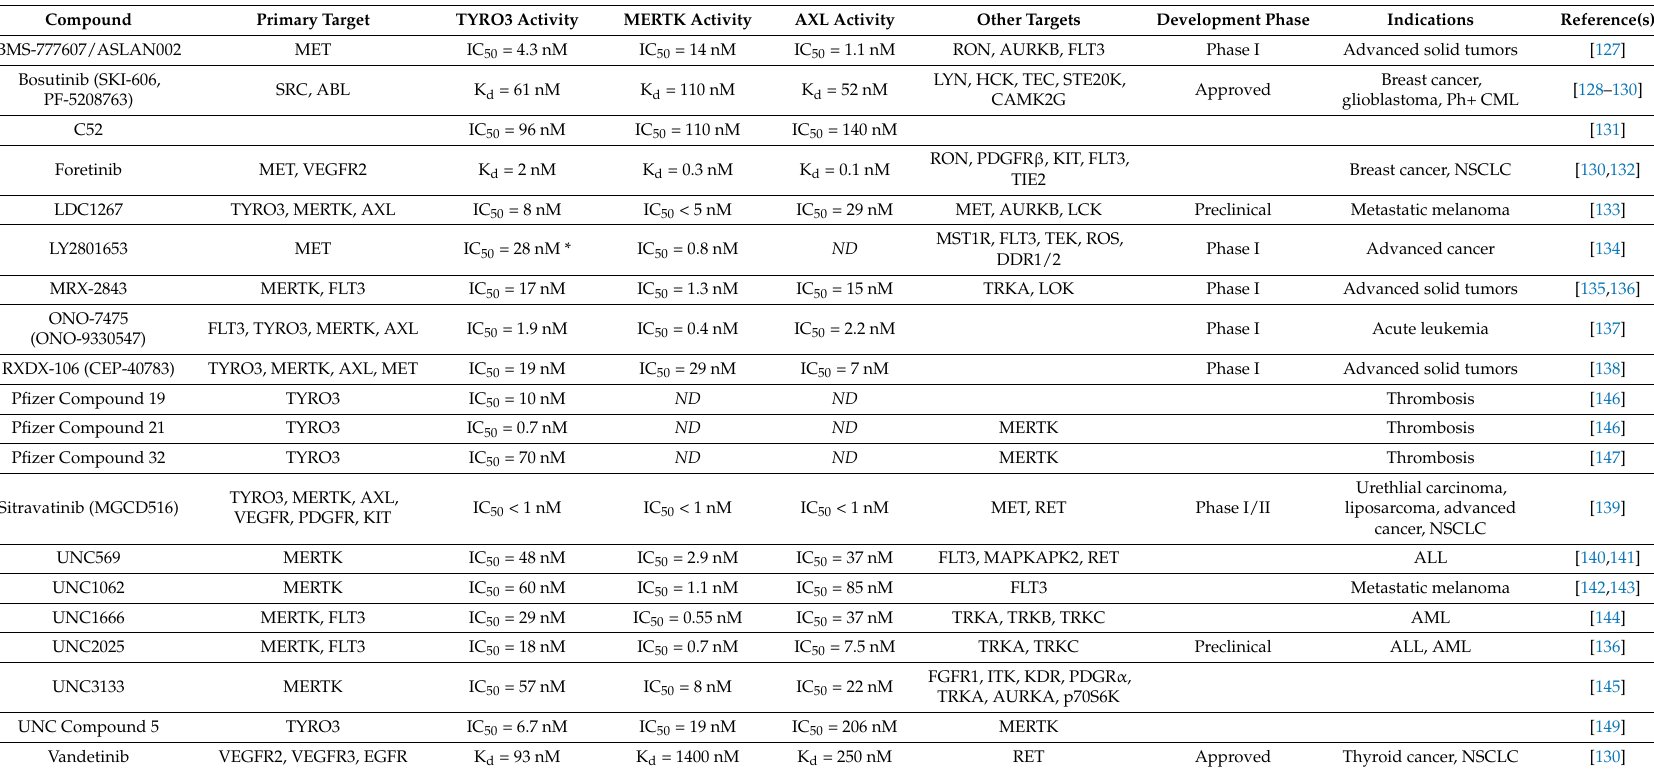
Table 2. Translational agents targeting TYRO3. Tyrosine kinase inhibitors with IC 50 or K d values less than 100 nM are shown. Unless otherwise indicated values refer to activity in enzymatic assays. (* Cell-based assay, ND = Not Determined).